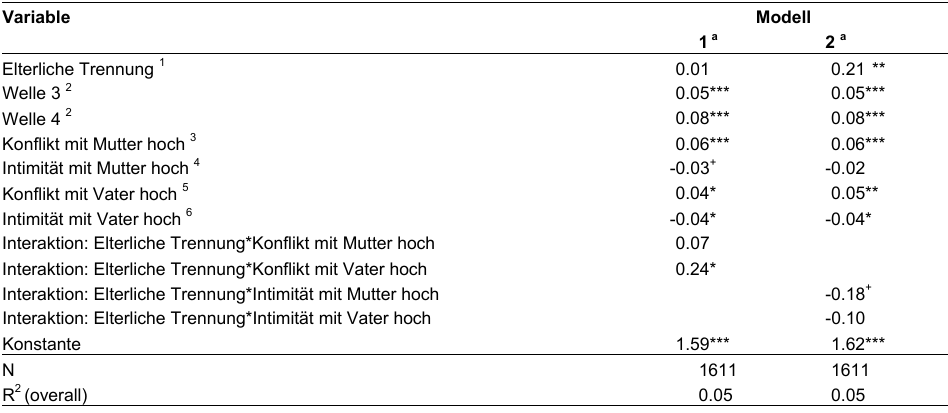
Tabelle 3 : Regression elterlicher Trennung auf Depressivität